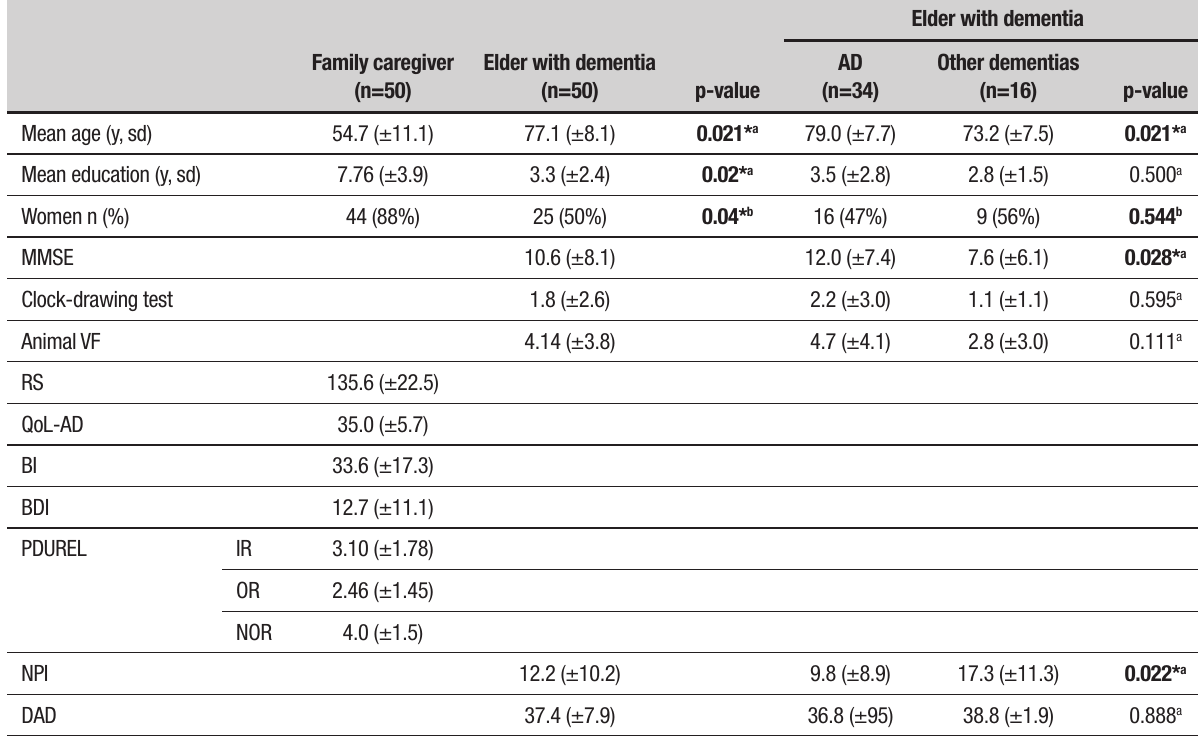
Table 1. Sociodemographic and clinical aspects.